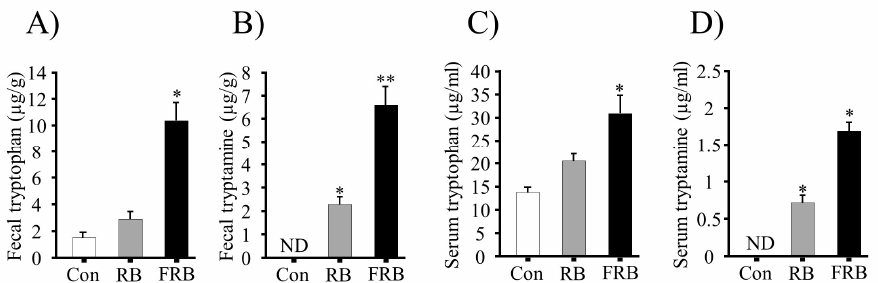
Figure 3. The involvement of fermented rice bran (FRB) in tryptophan and tryptamine production. ( A ) Fecal tryptophan; ( B ) fecal tryptamine; ( C ) serum tryptophan; and ( D ) serum tryptamine levels. The values are expressed as the mean ± SEM ( n = 4); one-way ANOVA was done followed by Dunnett’s test. * p < 0.05, compared with the control (Con) group. RB, rice bran. Table 2. Concentration of short-chain fatty acids (SCFAs; µ mol/g) in the feces and colon tissue. Feces Colon Control RB FRB